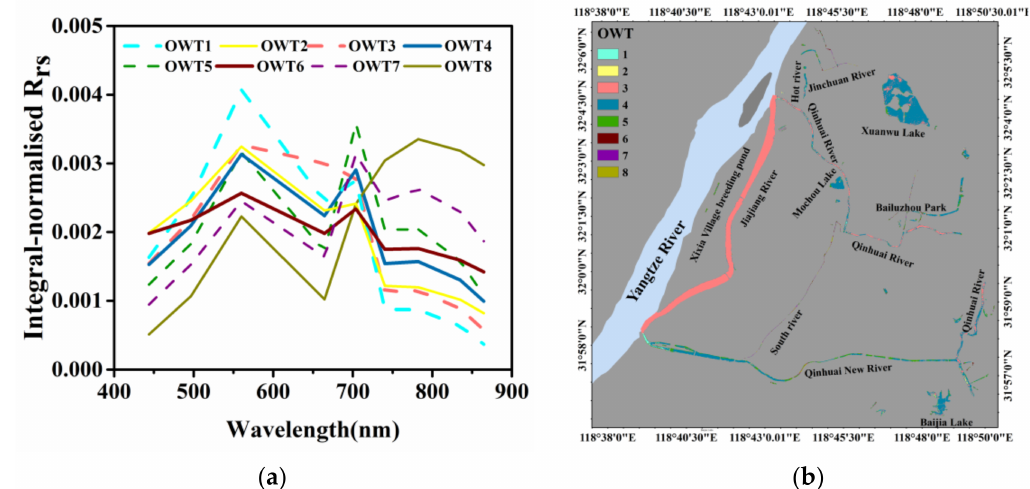
Figure 4. Standardized spectral curves of OWTs based on the Sentinel-2 MSI spectral channel ( a ). The distribution of OWTs in the built-up area of Nanjing on 19 July 2017, based on a Sentinel-2 MSI image ( b ).